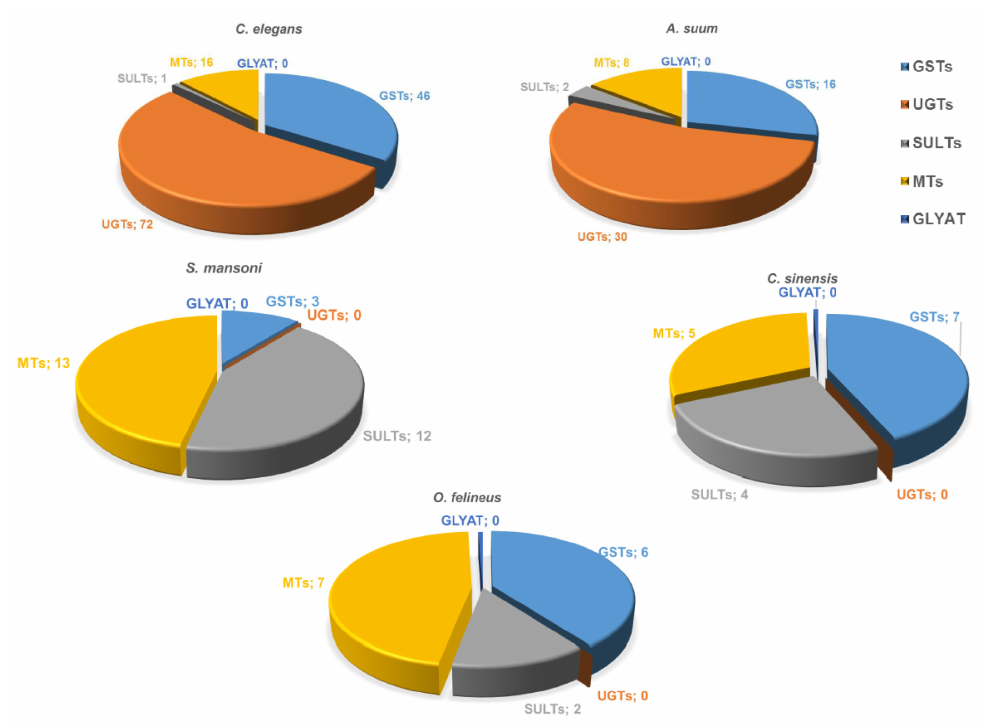
Figure 3. The spectrum of annotated nematode and trematode genes containing conserved domains of “conjugation phase II” proteins. GST, glutathione S transferase; SULT, sulfotransferase; UGT, UDP- glucuronosyl transferase; GLYAT, glycine-N-acyltransferase; and MT, methyltransferase. Numbers represent the number of genes identified in the